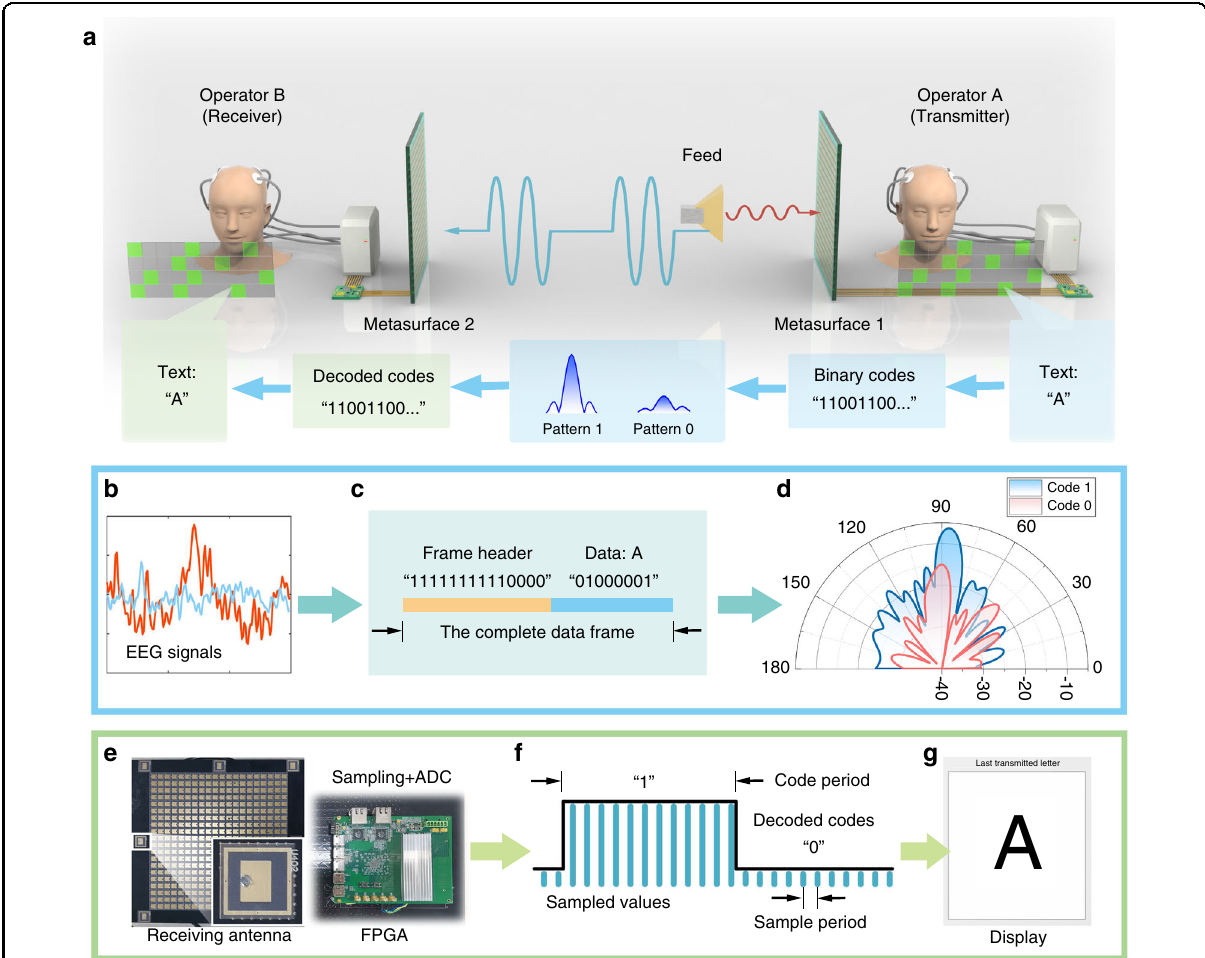
Fig. 1 The wireless text-communication using EBCM. a The system architecture of the text-communication system as well as the coding and decoding process. The encoding process from EEG signals to the transmitted EM signals, where the EEG signals shown in ( b ) are fi rst detected by BCI and translated into the digital sequence in ( c ) for wireless transmission, then radiated by the metasurface with different pattern amplitudes in ( d ). e – g The decoding process of wireless communication, where the antenna and FPGA in ( e ) fi rstly receive and sample the signals from space and convert them into the digital signals. The sampled data are discretized into 0/1 codes for decoding, as depicted in ( f ) and fi nally translated into the text for display. Reprinted with permission from Ref. 8 , Copyright